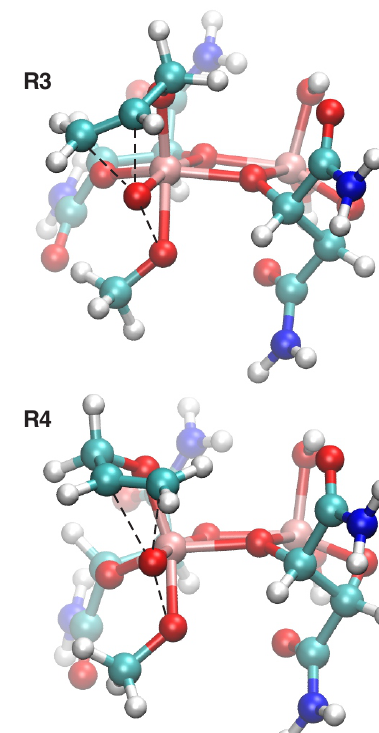
ing local mode force constants k a (OO) utilizing the power relationship described